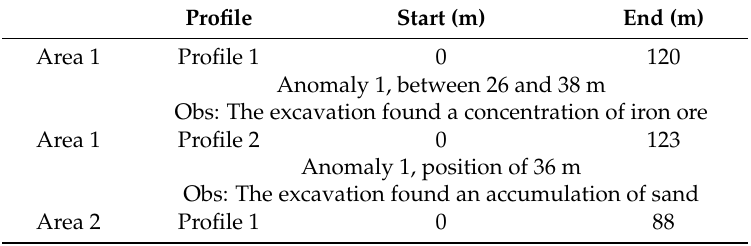
Table 1. Start/end of the GPR profiles acquired in areas 1 and 2 (Figure 3), the position of the observed anomalies in each profile, and the result of the